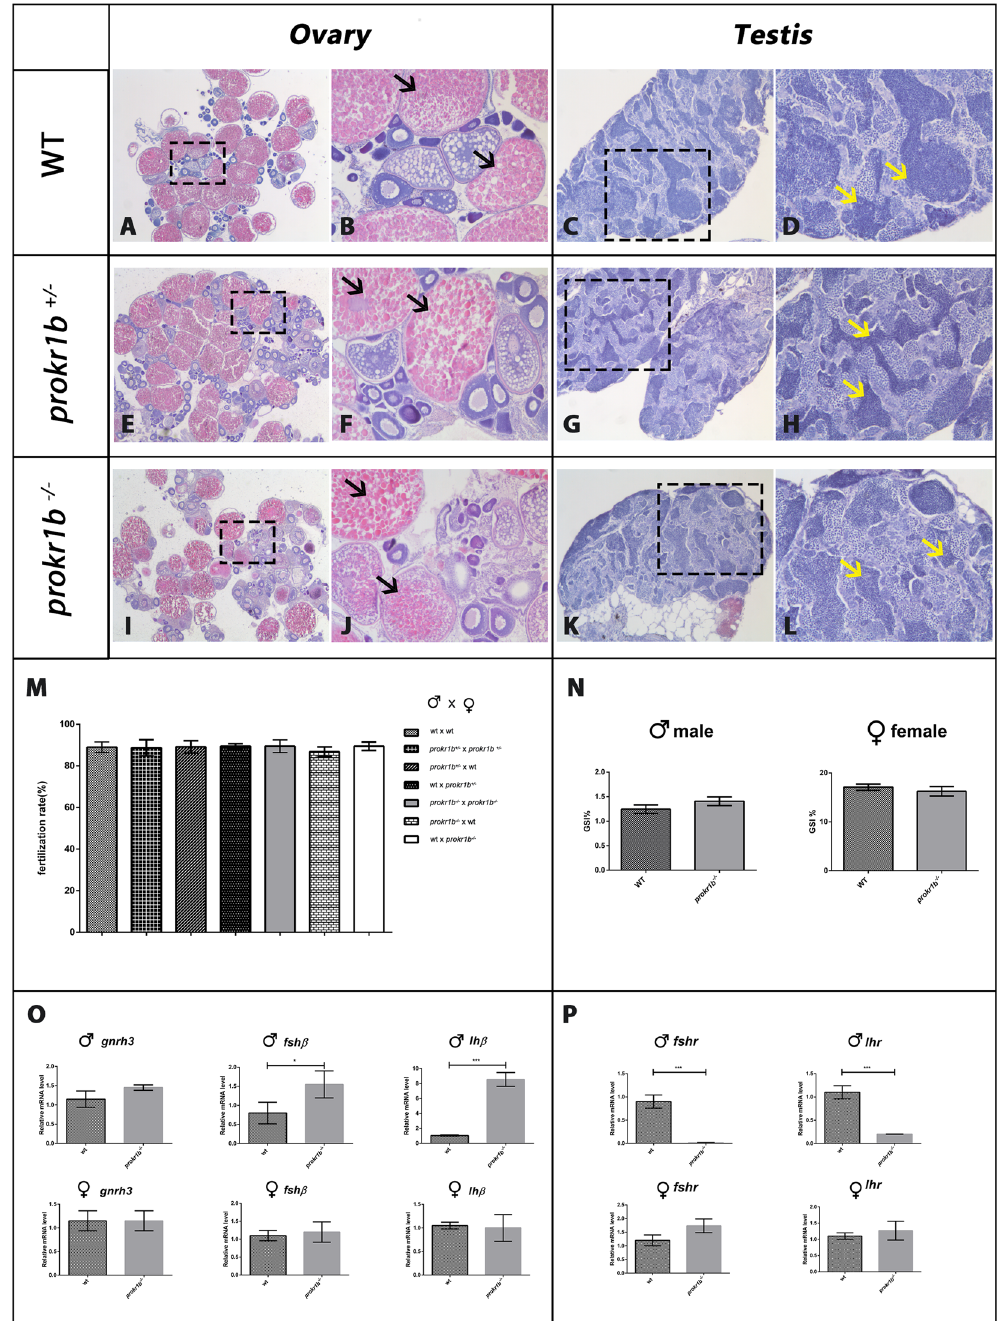
Figure 6. Histological sections conducted on 3 months of age fish showed no defects in the structure of gonads and testis between WT ( A,C ), heterozygous ( E,G ) and homozygous mutant ( I,K ). Sections zoomrevealed fully mature oocytes (black arrows in B,F,J ) and fully mature spermatozoa (yellow arrows in D,H,L ) in WT, prokr1b + / − and prokr1b − / − animals. Comparison of reproductive outputs ( M ) and GSI index ( N ) revealed no differences between WT, heterozygous and homozygous mutants. Real-Time PCR conducted on brain ( O ) and gonads ( P ) of WT and mutant fish showed a different expression of lh β , fsh β , lhr and fshr in prokr1b − / − males. Image taken using Leica Application Suite software (LAS version 4.7.0; URL: https://www.leica-